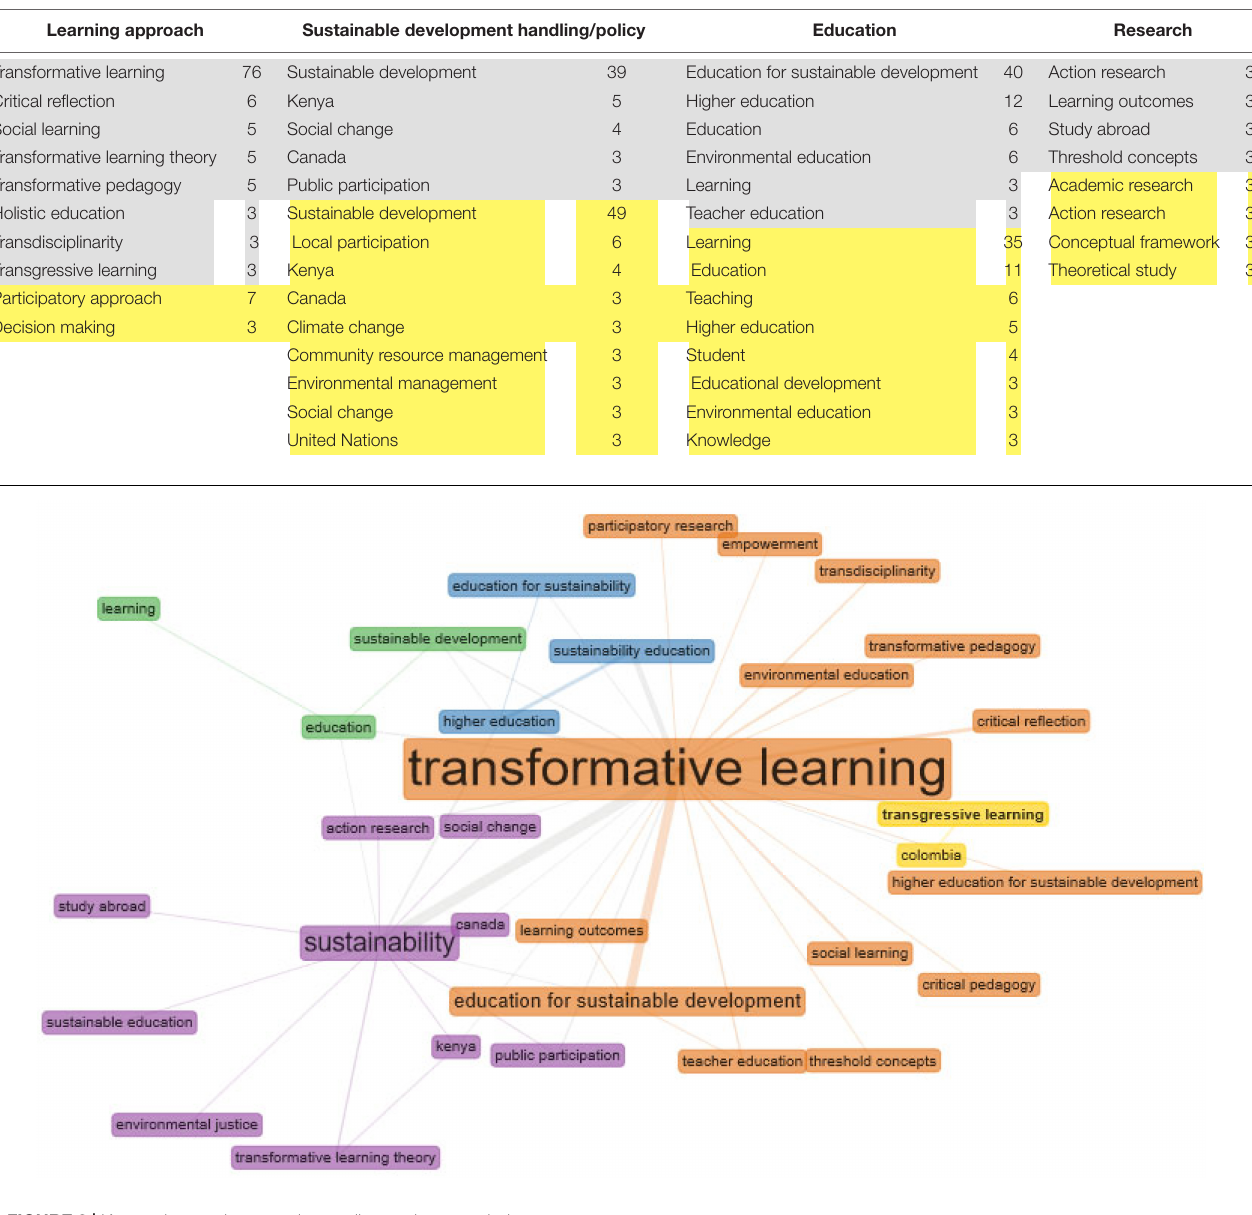
TABLE 5 | Main themes (Authors’ keywords in gray and keywords plus in yellow).